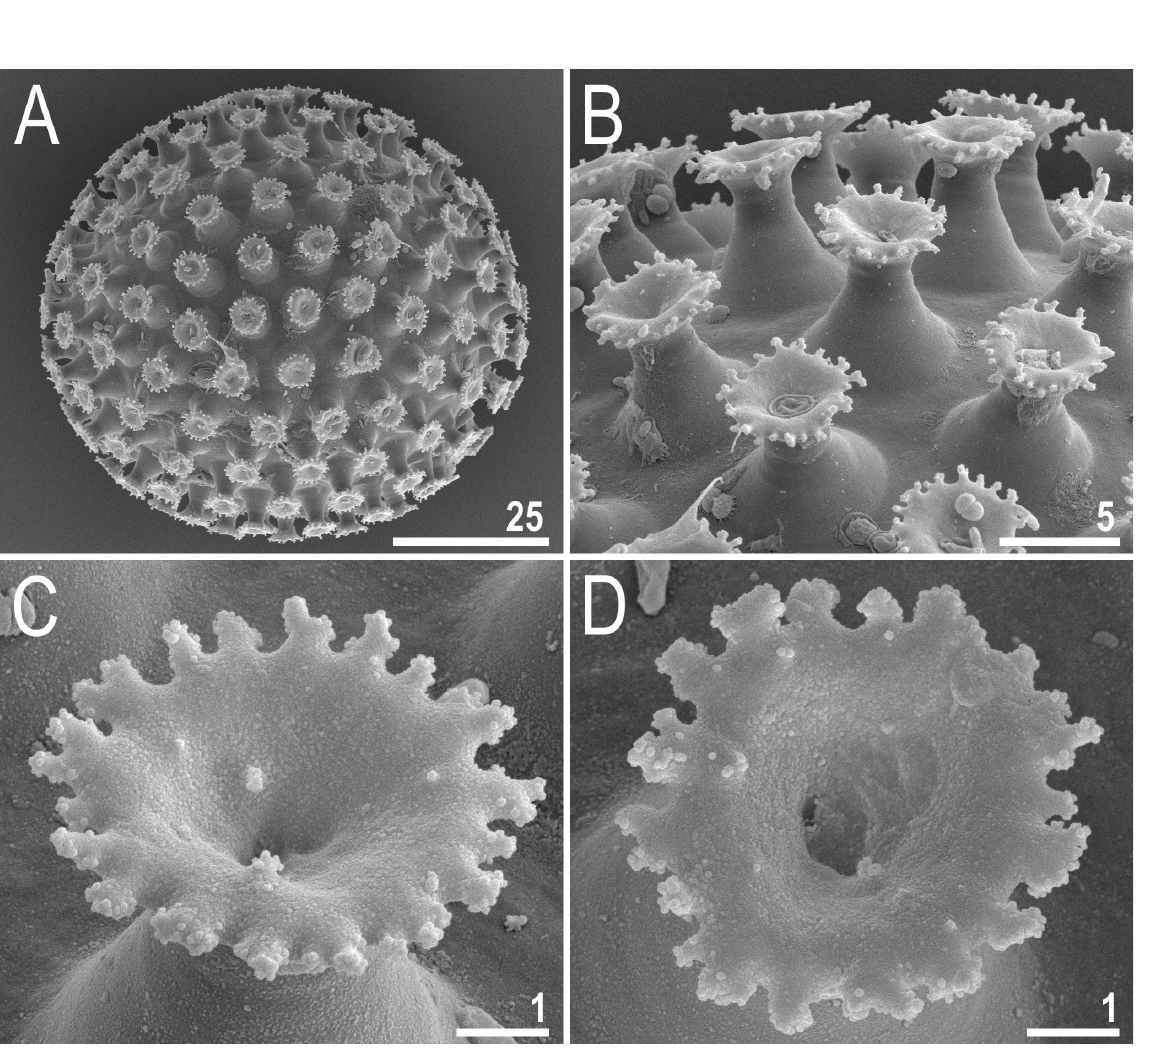
Fig. 8. Macrobiotus engbergi sp. nov. Egg chorion morphology seen in SEM. A . Entire egg. B . Magnification of the egg surface. C – D . Details of the terminal discs. Scale bars in